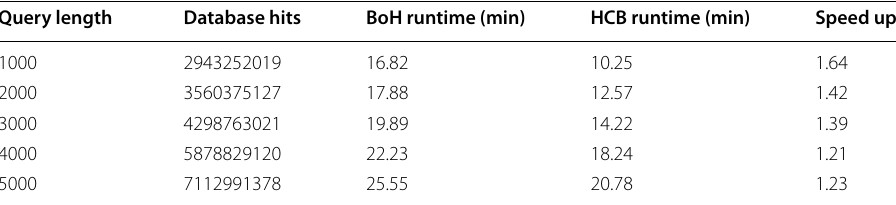
Table 2 Performance of HCudaBLAST compared to generic BLAST algorithm on Hadoop with 6M sequences (BoH: BLAST on Hadoop, HCB: HCudaBLAST) Query